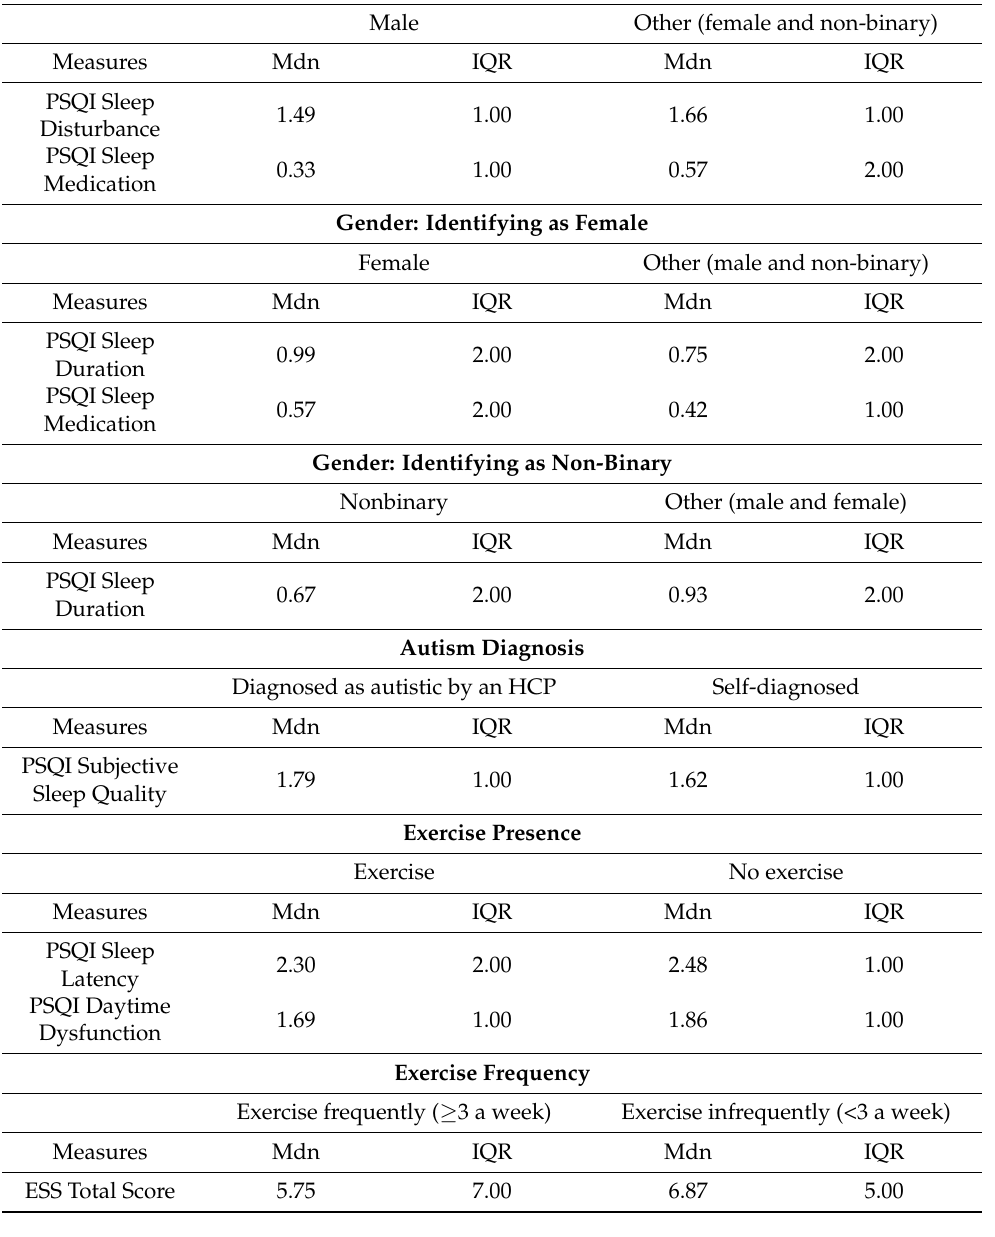
Table 3. Reported grouped median and interquartile range on significant sleep quality measures. Gender: Identifying as Male Male Other (female and